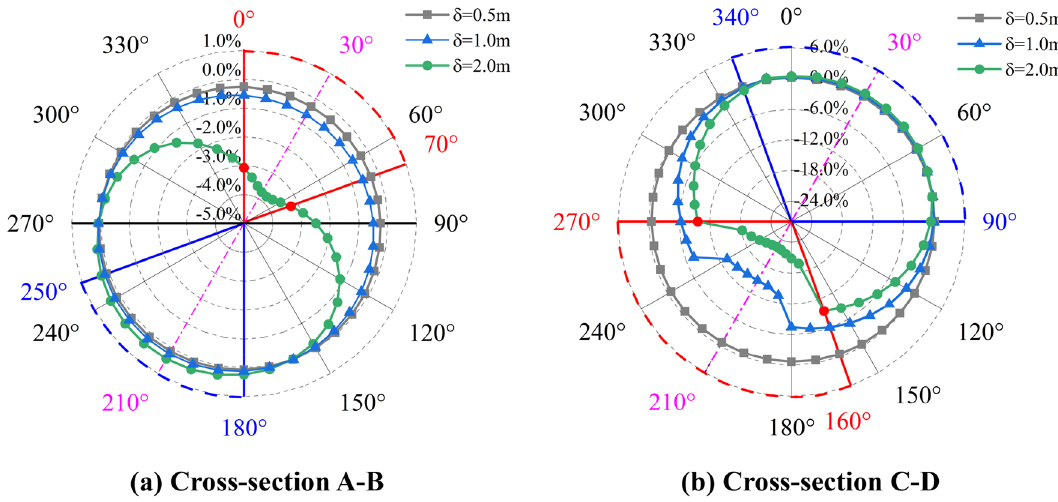
Figure 9. Variation of the Cross-section strain under oblique-reverse displacement ( β = 90°, ψ = 60°, h = 1.2 m, t = 22 mm, D = 1.219 m, P = 12 MPa).